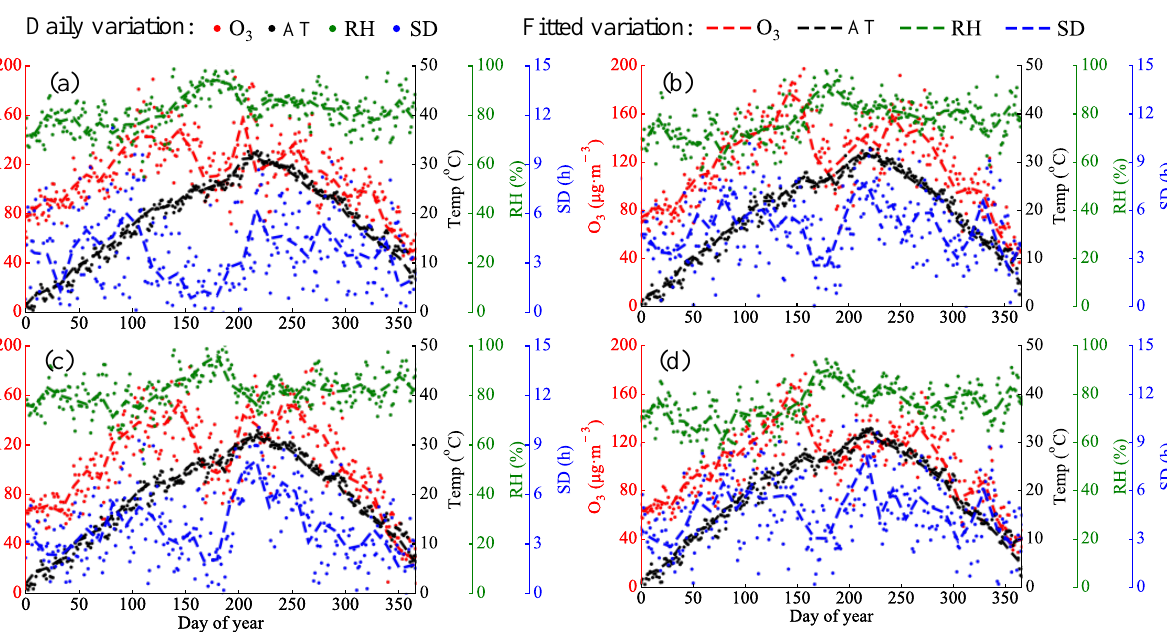
Figure A2. ( a ) Satellite observed Daily HCHO and NO 2 column densities, and ( b ) ground-level yearly NO 2 variation from dense measurements over the over the four capital cities (blue: Shanghai, black: Nanjing, red: Hangzhou, green: Hefei) in the Yangtze River Delta. References 1. Feng, Z.; De Marco, A.; Anav, A.; Gualtieri, M.; Sicard, P.; Tian, H.; Fornasier, F.; Tao, F.; Guo, A.; Paoletti, E. Economic losses due to ozone impacts on human health, forest productivity and crop yield across China. Environ. Int. 2019 , 131 , 104966. https://doi.org/10.1016/j.envint.2019.104966. 2. Sicard, P.; Augustaitis, A.; Belyazid, S.; Calfapietra, C.; Marco, A.D.; Fenn, M.; Bytnerowicz, A.; Grulke, N.; He, S.; Matyssek, R. Global topics and novel approaches in the study of air pollution, climate change and forest ecosystems. Environ. Pollut. 2016 , 213 , 977 – 987. https://doi.org/10.1016/j.envpol.2016.01.075. 3. Stocker, T.; Qin, D.; Plattner, G.; Tignor, M.; Allen, S.; Boschung, J.; Nauels, A.; Xia, Y.; Bex, B.; Midgley, B. IPCC, 2013: Climate Change 2013: The Physical Science Basis — Contribution of Working Group I to the Fifth Assessment Report of the Intergovernmental Panel on Climate Change ; Cambridge University Press: Cambridge, UK, 2013. https://doi.org/10.1017/CBO9781107415324. 4. Juráň, S.; Grace, J.; Urban, O. Temporal Changes in Ozone Concentrations and Their Impact on Vegetation. Atmosphere 2021 , 12 , 82. https://doi.org/10.3390/atmos12010082. 5. Xu, J.; Huang, X.; Wang, N.; Li, Y.; Ding, A. Understanding ozone pollution in the Yangtze River Delta of eastern China from the perspective of diurnal cycles. Sci. Total Environ. 2021 , 752 , 141928. https://doi.org/10.1016/j.scitotenv.2020.141928. 6. Lin, C.; Lau, A.K.H.; Fung, J.C.H.; Song, Y.; Li, Y.; Tao, M.; Lu, X.; Ma, J.; Lao, X.Q. Removing the effects of meteorological factors on changes in nitrogen dioxide and ozone concentrations in China from 2013 to 2020. Sci. Total Environ. 2021 , 793 , 148575. https://doi.org/10.1016/j.scitotenv.2021.148575.